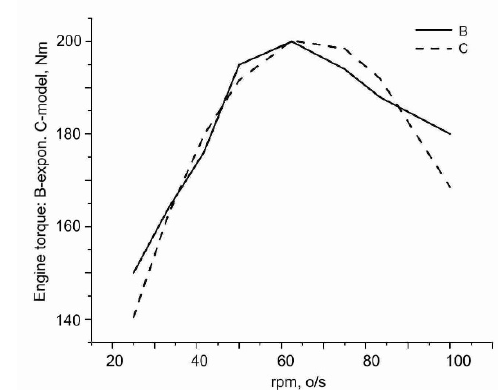
Figure 5 – Torque of the applied engine Рис . 5 – Крутящий момент испытуемого двигателя